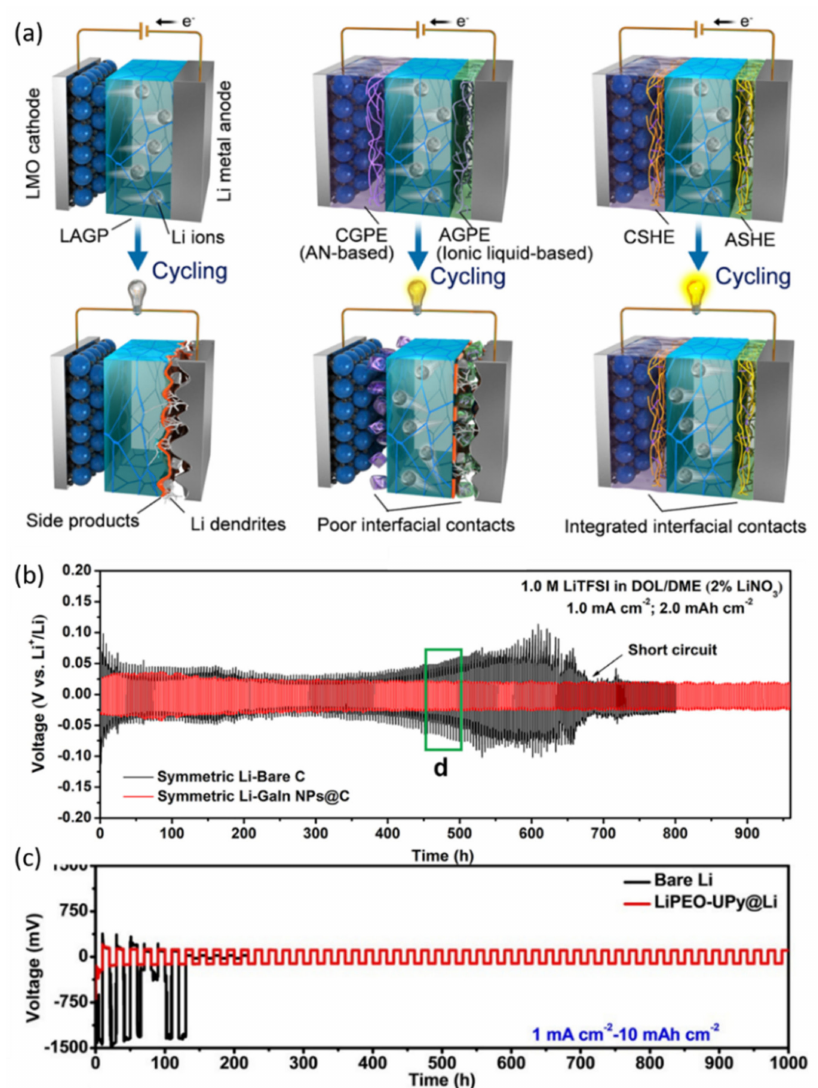
Figure 9. ( a ) Schematic illustrations of Li|LAGP|LMO batteries without interface layers and with GPEs and SHEs [19]. Copyright 2020, American Chemical Society; ( b ) voltage − time profiles of Li plat- ing/stripping in Li-Bare C and Li-GaIn NPs@C symmetric cells at 1.0 mA cm − 2 for 2.0 mAh cm − 2 [98]. Copyright 2021, American Chemical Society; ( c ) voltage profiles of bare Li and LiPEO–UPy@Li anodes in symmetric cells at 1 mA cm − 2 under 10 mAh cm − 2 [99]. Copyright 2020, John Wiley and